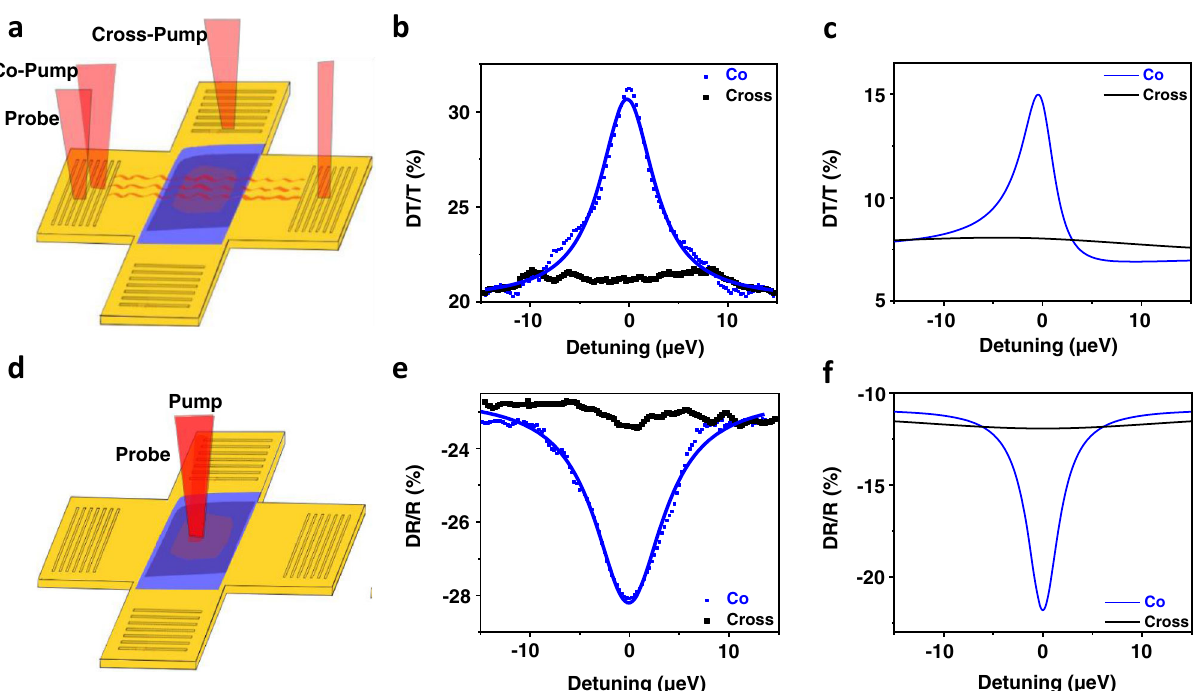
Fig. 2 | Polarization dependence of the coherent population oscillation effect. a Depiction of the surface plasmon polariton (SPP) pump and SPP probe con fi g- uration. b High-resolution normalized differential transmission spectra (DT/T) for SPPpumpandSPPprobe.Thebluepointscorrespondtoco-propagatingwhichare with to a Lorentzian (blue curve), and the black correspond to cross-propagating. c TheoreticalDT/TforSPPpumpandSPPprobe.Thebluecurvecorrespondstoco- propagating, and the black corresponds to cross-propagating. d Depiction of the